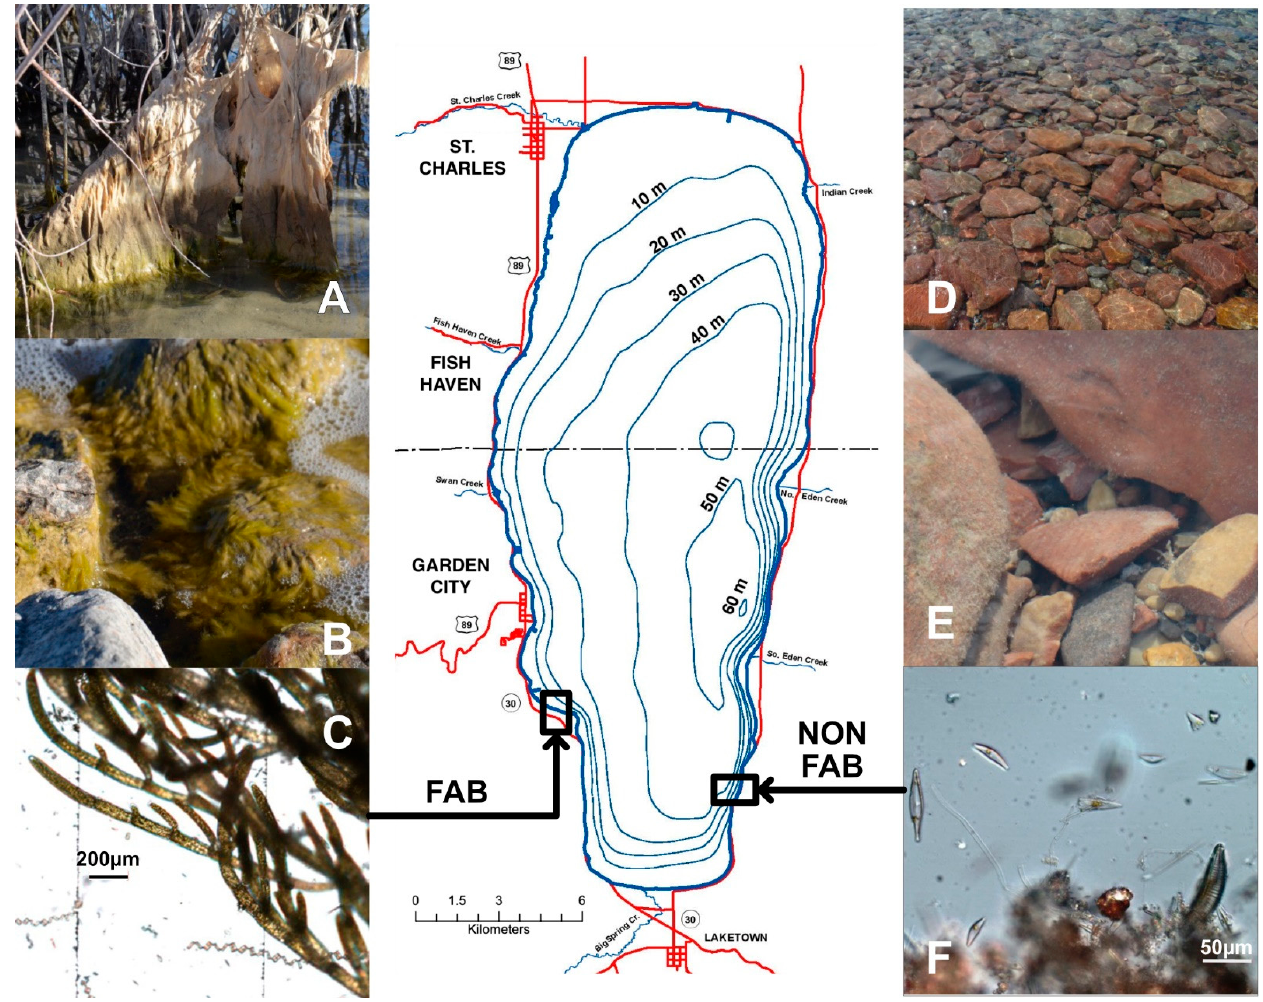
Figure 1. Bear Lake at the border of Idaho (ID) and Utah (UT) with infrastructure (red), major tributaries, and sampling locations of filamentous algae blooms at the western shore (FAB site) and non-filamentous algae at the eastern shore (non-FAB site). At the FAB site, aquatic plants ( A ) and rocks ( B ) were densely covered by filamentous algae during all sampling campaigns (October 2019; June, July, and October 2020; and June 2021), which mainly comprised Cladophora glomerata (microscope image ( C )). Periphyton on the rocky substrate at the non-FAB site ( D , E ) were dominated by various diatoms ( Epithemia , Gomphonema , Cymbella ; ( F )). Photos by Soren Brothers (non-FAB), Sabine Hilt (FAB) and Katrin Preuß